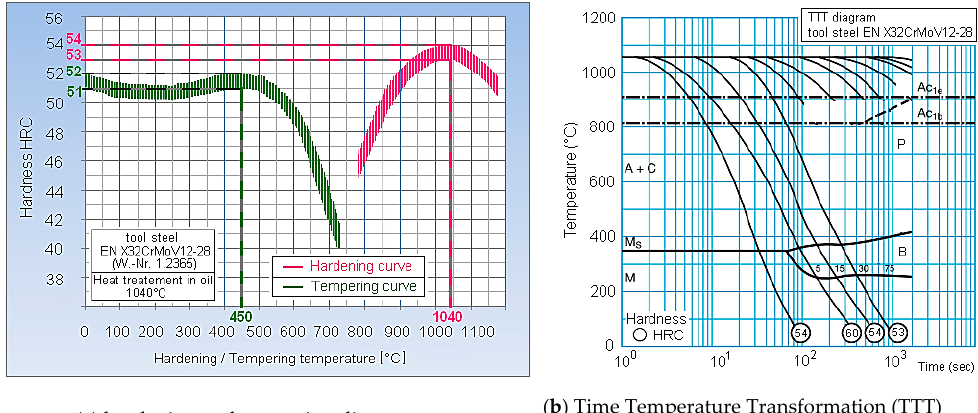
Figure 2. Hardening, tempering and TTT diagram of tool steel EN X32CrMoV12 ‐ 28 [18].